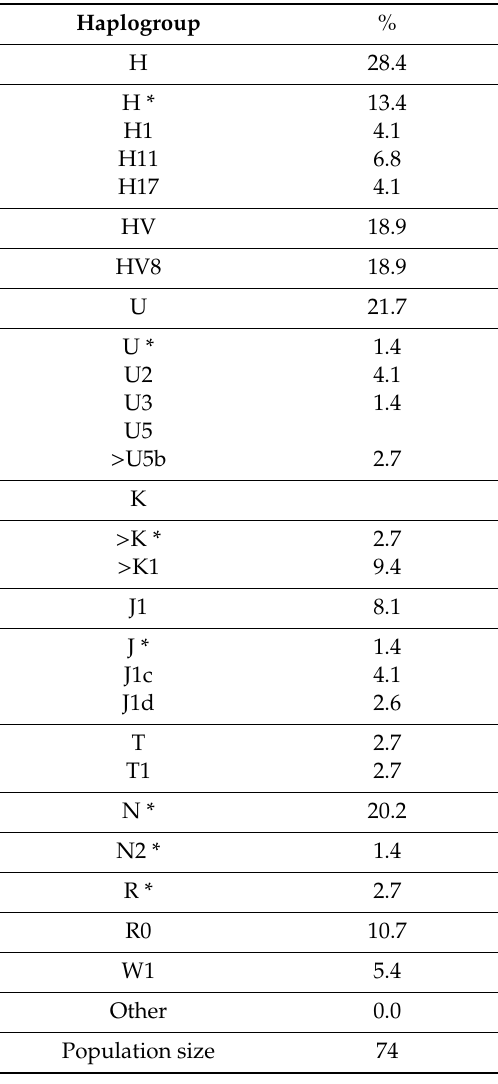
Table 2. mtDNA haplogroup frequencies (%) in the Galiˇcnik population. Lineages defined by the presence of a derived marker and the absence of the derived state at other markers are potentially paraphyletic and under the present nomenclature are di ff erentiated by an asterisk (*), unless they are known to be